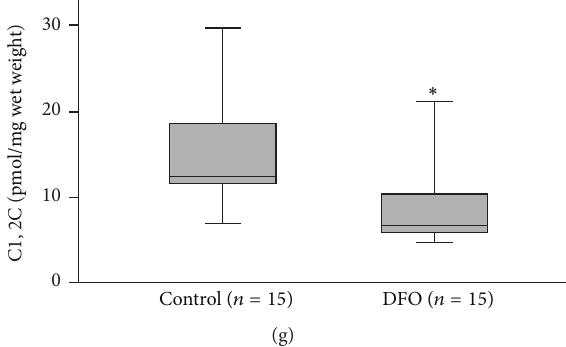
Figure 2: Deferoxamine (DFO) inhibition of type II collagen cleavage by collagenase in human osteoarthritic (OA) articular explants from patients whose ages and genders are indicated (a–e). The means ± SDs for all five patients are shown in (f) (Wilcoxon matched pairs test). Inhibition of type II collagen cleavage by collagenase in human OA articular explants by 10 𝜇 M DFO. Cartilages from an additional 15 OA articularcartilageexplantswereanalyzedafterexposureto10 𝜇 MDFO.Themeans ± SDsareshownin(g)(Mann–Whitney 𝑈 test).Significant differences compared to the control ( 𝑝 < 0.05 ) are indicated by asterisks ( ∗ ).